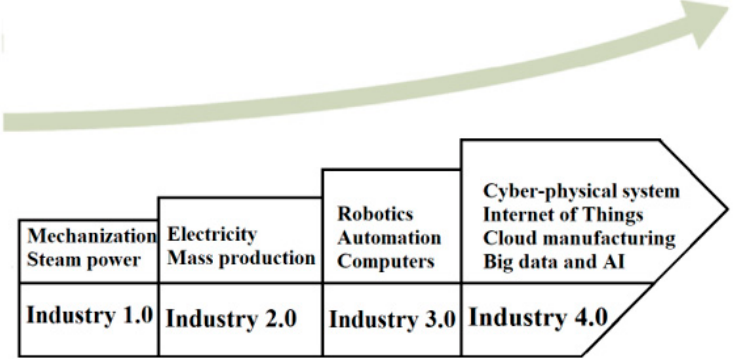
Figure 12. Historical Evolution of Industry 1.0 to Industry 4.0.